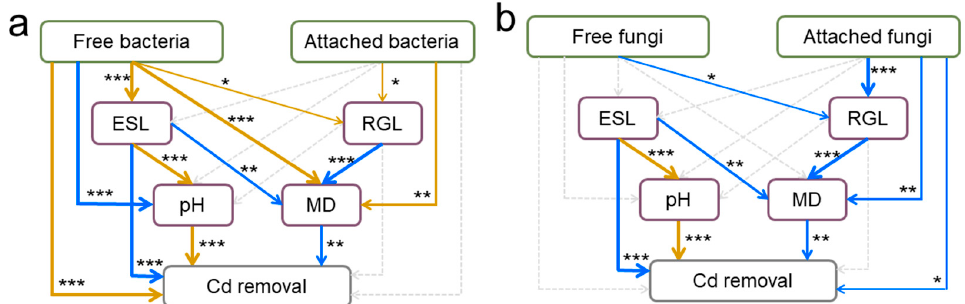
Figure 5. Associations of free and attached microbial communities (PCoA 1), solution environmental factors, and soil Cd removal: ( a ) bacteria; ( b ) fungi. Solution environmental factors include pH, MD (microbial density), ESL (elevated sulfate radical level), and RGL (reduced glucose level). Blue and yellow solid arrows indicate the positive and negative effects, respectively. Gray dashed arrows indicate non-significant effects. Level of significance: * p < 0.05, ** p < 0.01, *** p < 0.001.